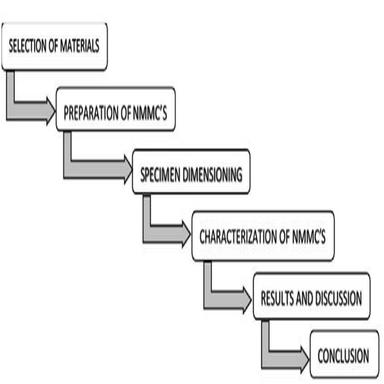
Schematic Overview of Methodology.